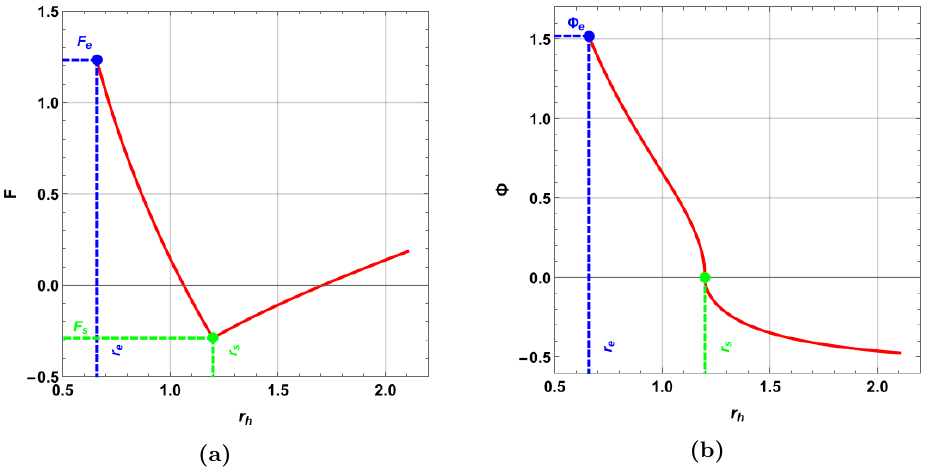
Figure 11. (a) Free energy and (b) electric potential as a function of black hole event horizon during absorption of 10 3 particles with a fixed electric charge dQ = − 0 . 002 . The initial conditions are Q = 1 , l = 1 , M = 1 . 23 , r h = 0 . 65 and D = 4